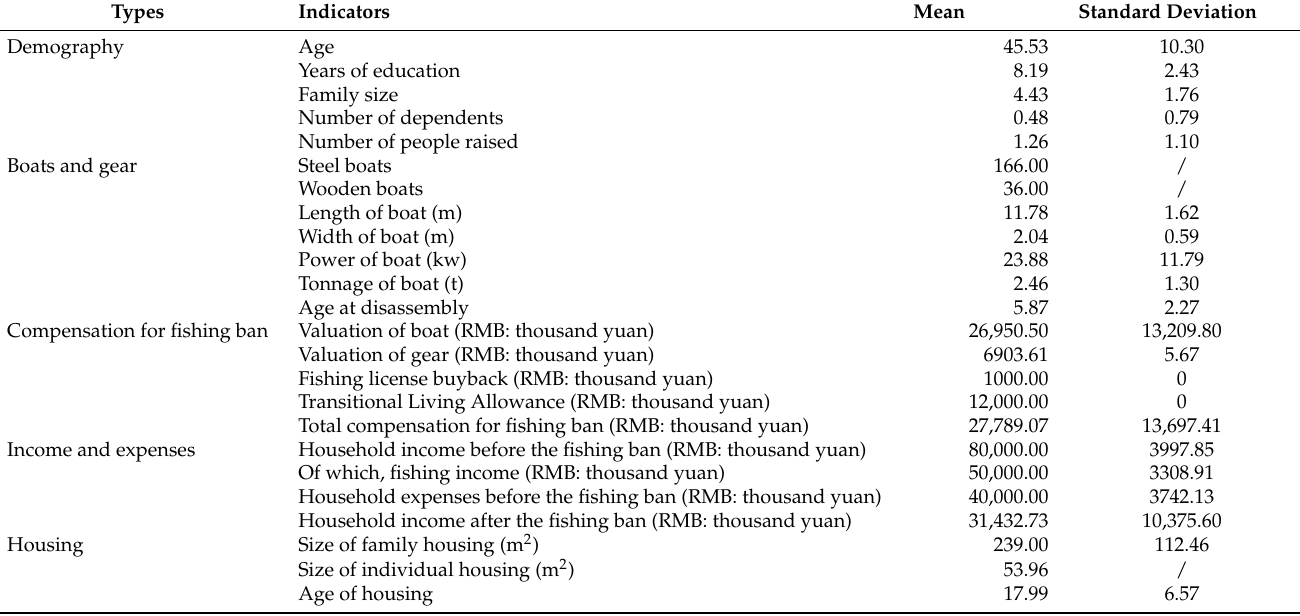
Table 1. Statistics on the basic characteristics of